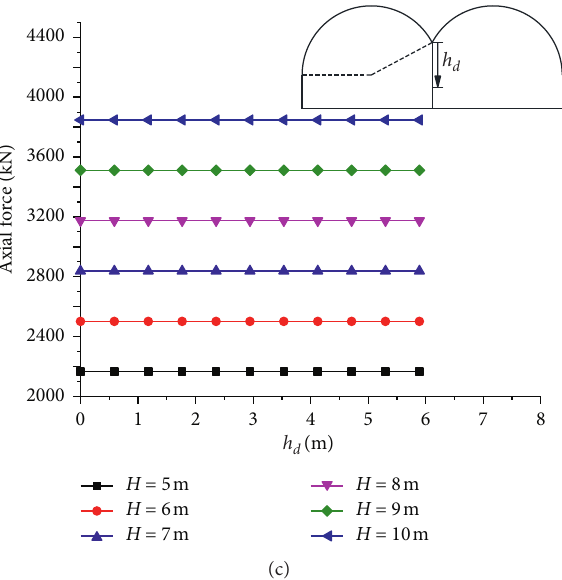
Figure 12: Variations of axial force with ( H ): (a) along the arch ring; (b) along the side wall; (c) along the middle wall